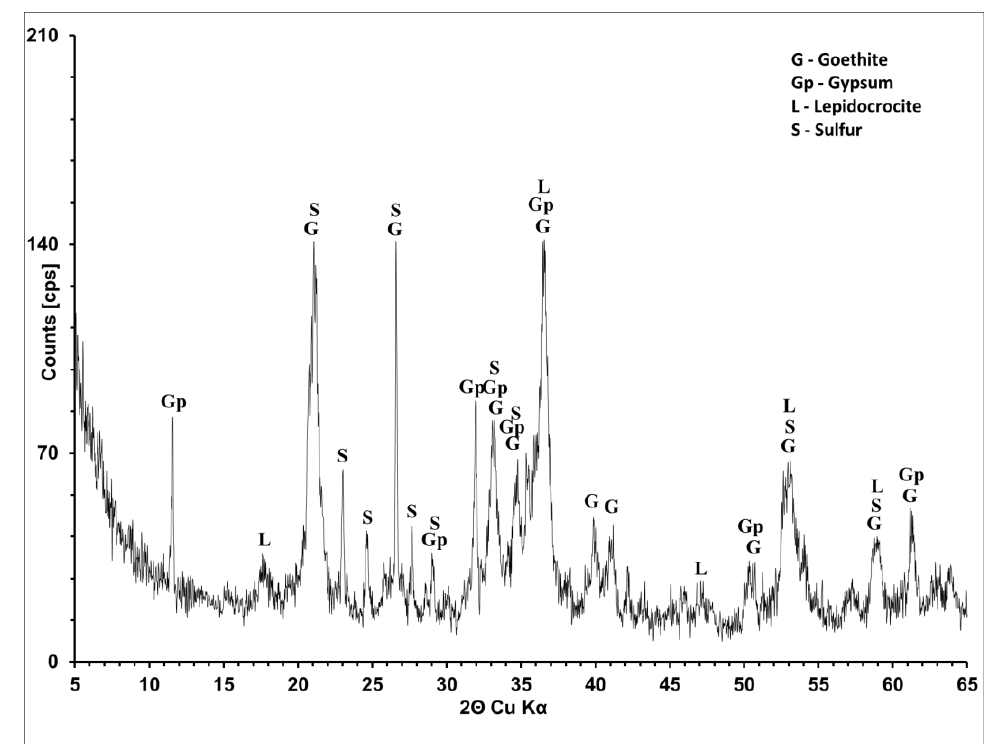
Figure 6. Diffraction pattern of the sediment mineral composition.